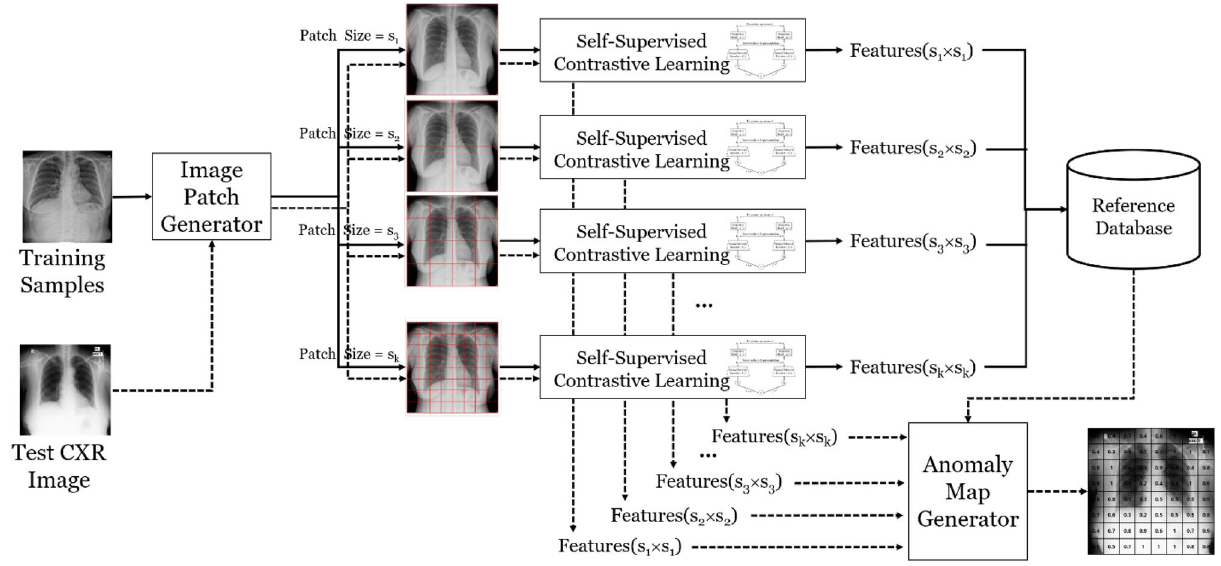
Figure 1. Overall process of anomaly detection in CXR